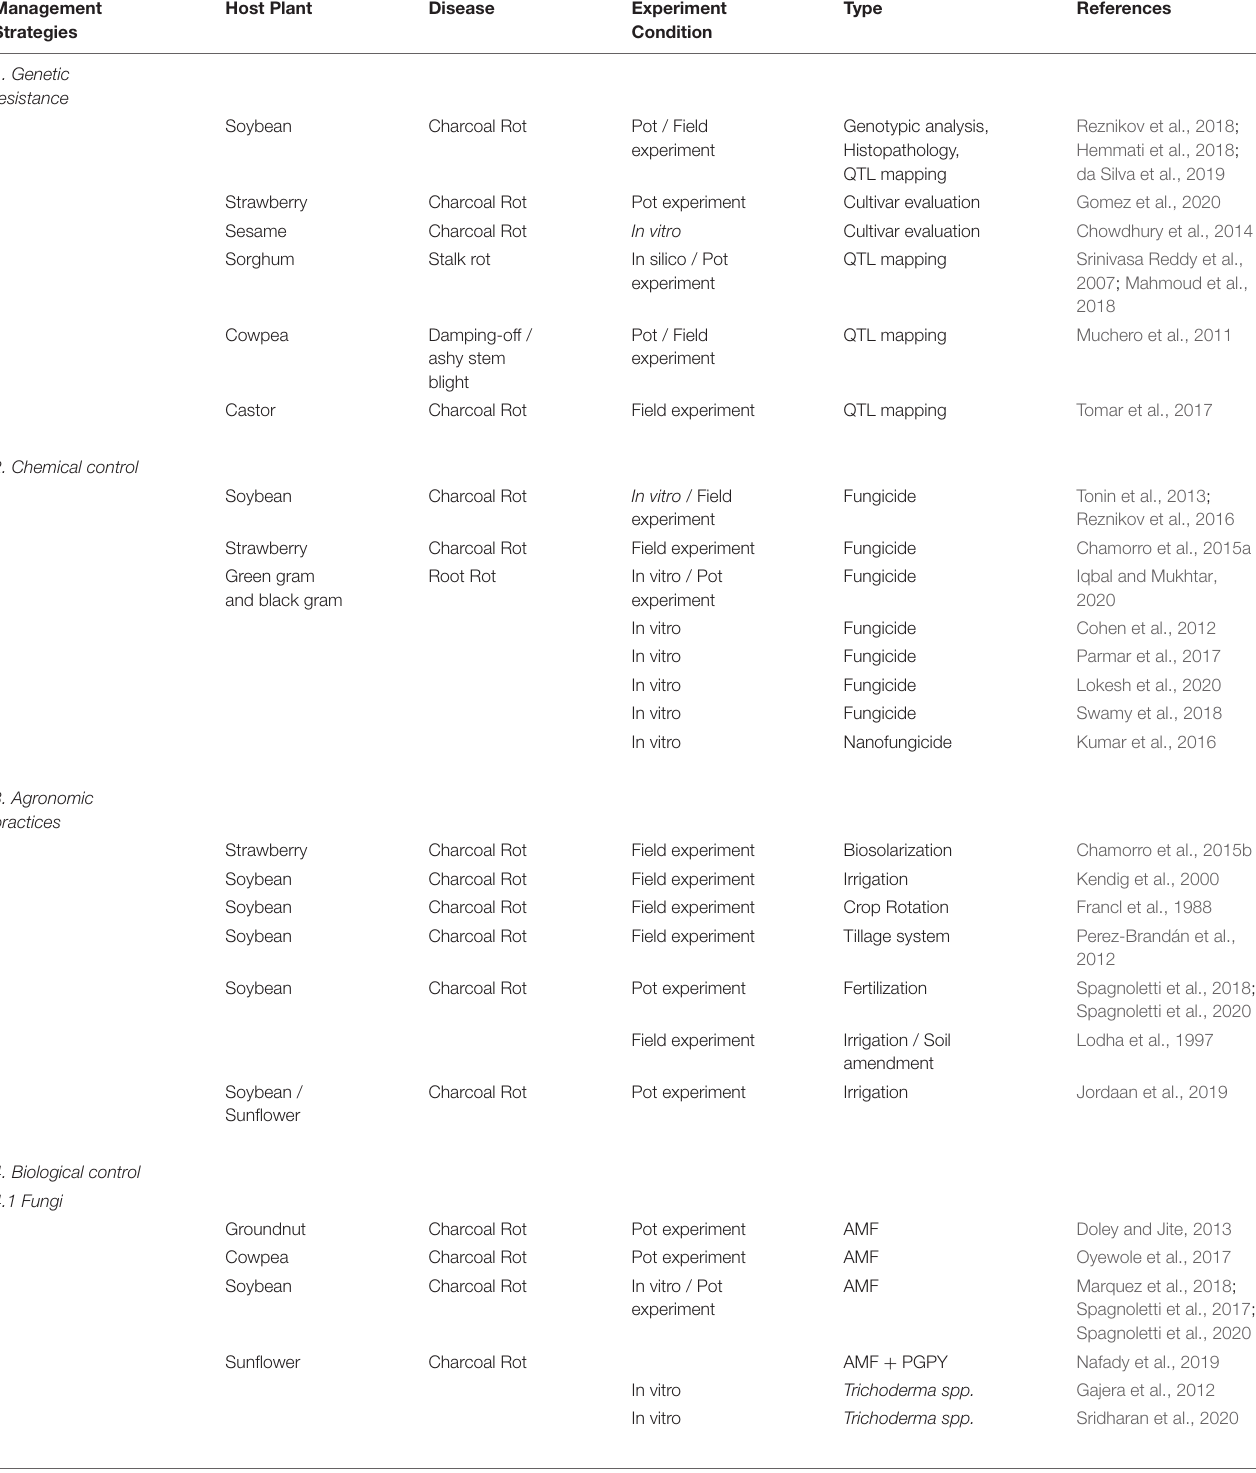
TABLE 2 | Summary of different management strategies against Macrophomina phaseolina . Management